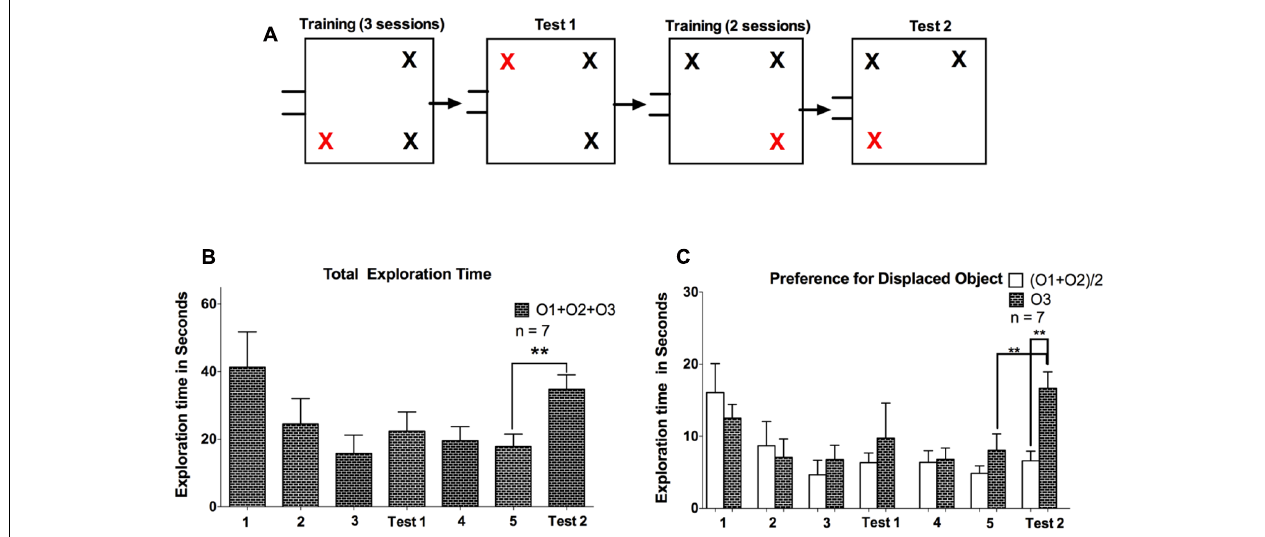
FIGURE 3 | (A) Representation of training and subsequent test phases in Experiment 2.Two training phases composed of three and two sessions were conducted; each followed by a test session in which one object was displaced. O3 marks the displaced object. (B) The total exploration time spent